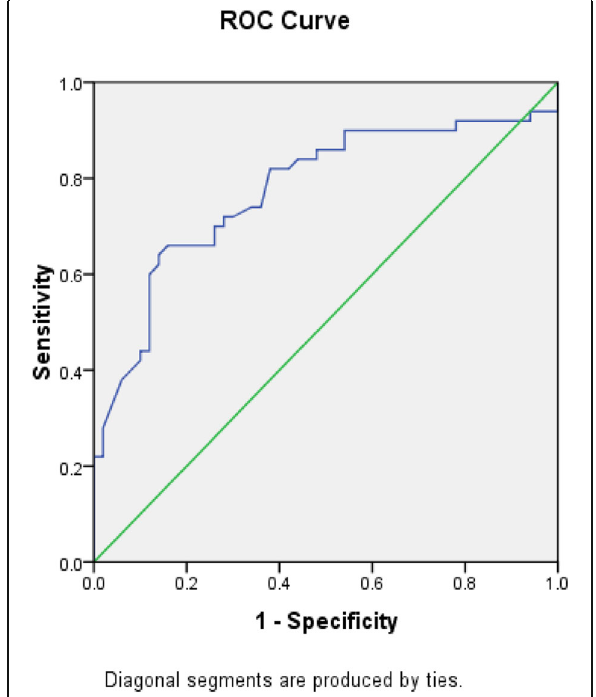
Fig. 2 ROC curve for detection of neurological dysfunction using total serum bilirubin in all patients